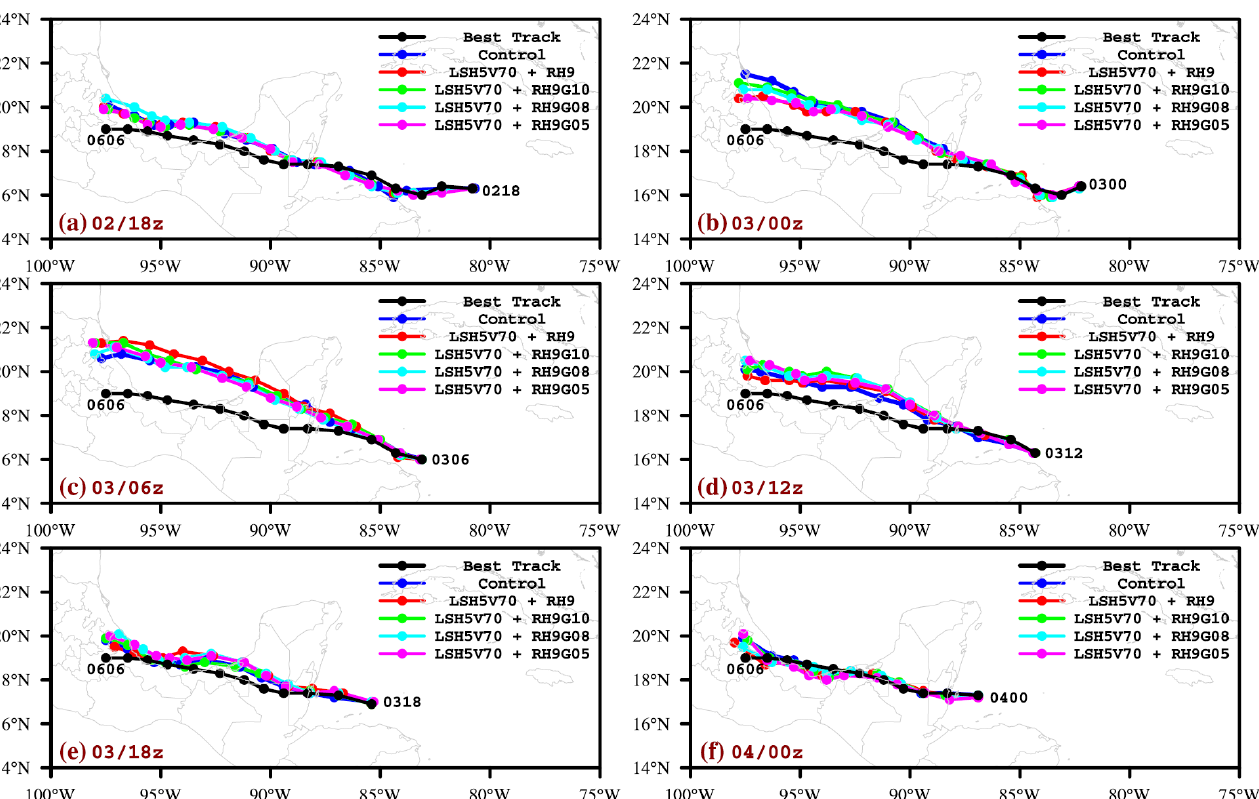
Figure 13. Comparison of the forecast track for Hurricane Earl for Control, LSH5V70 + RH9, LSH5V70 + RH9G10, LSH5V70 + RH9G08, and LSH5V70 + RH9G05 at ( a ) 18 UTC 2, ( b ) 00 UTC 3, ( c ) 06 UTC 3, ( d ) 12 UTC 3, ( e ) 18 UTC 3, and ( f ) 00 UTC 4 August 2016.